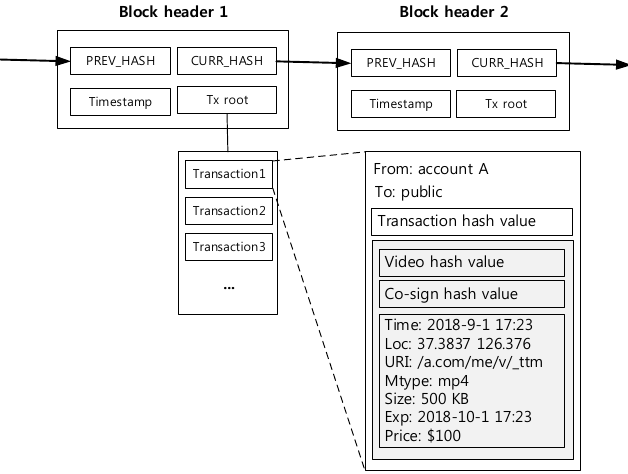
Figure 2. Block structure in a vehicular